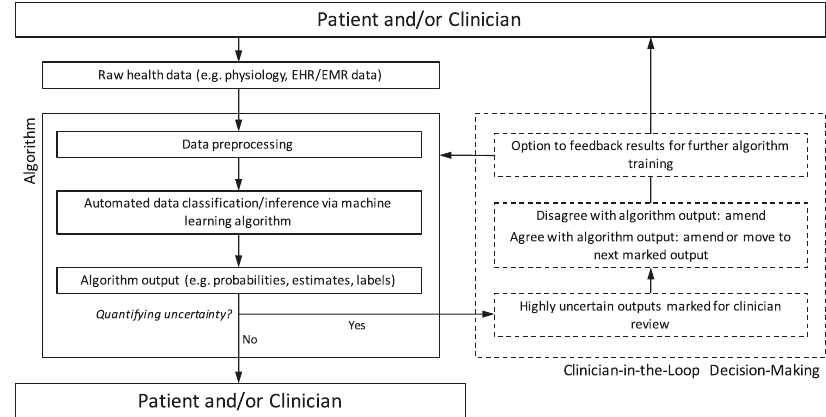
Fig. 2 Generalized work fl ow diagram for clinician (human) in-the-loop classi fi cation. With measures of uncertainty, data can be reviewed by expert clinicians or used for further algorithm